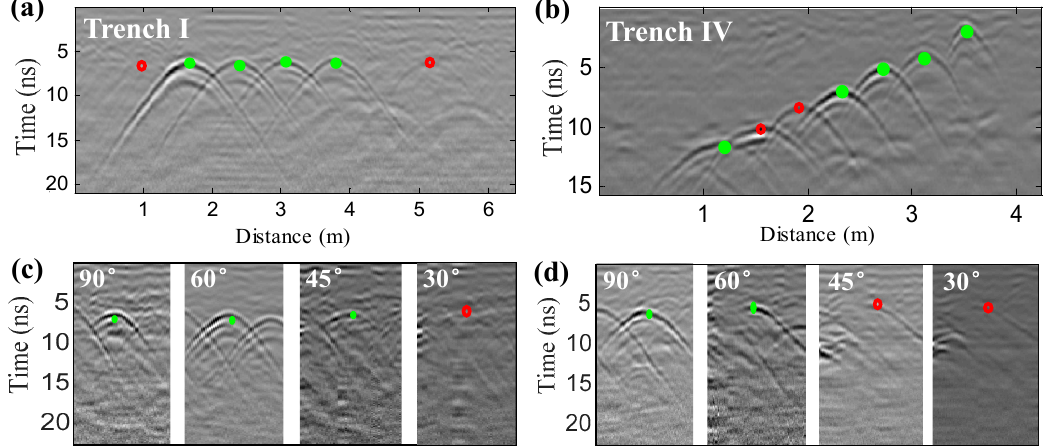
Figure 5. Results of recognition by RHT in controlled experiments for: ( a ) different root diameters; ( b ) different root depths; ( c ) a root with a diameter of 1.50 cm at azimuth angles of 90 ˝ , 60 ˝ , 45 ˝ , and 30 ˝ without vertical inclination; and ( d ) a root with a diameter of 1.85 cm at azimuth angles of 90 ˝ , 60 ˝ , 45 ˝ , and 30 ˝ and a vertical inclination of 30 ˝ . The roots correctly recognized by RHT were marked as green points and missed roots were marked as red circles. These radargrams were obtained using GPR with center frequency of 900 MHz. Figure 5a,b shows the corresponding results for experiments shown in Figure